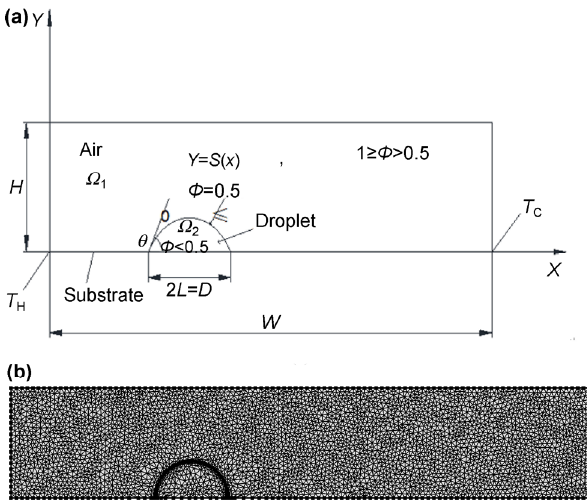
Fig. 1 (a) Theoretical model of thermocapillary migration. (b) Schematic meshing of